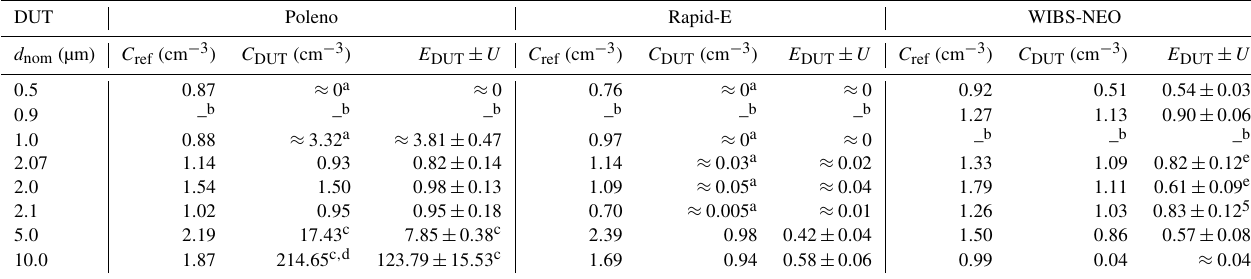
DUT Poleno Rapid-E WIBS-NEO